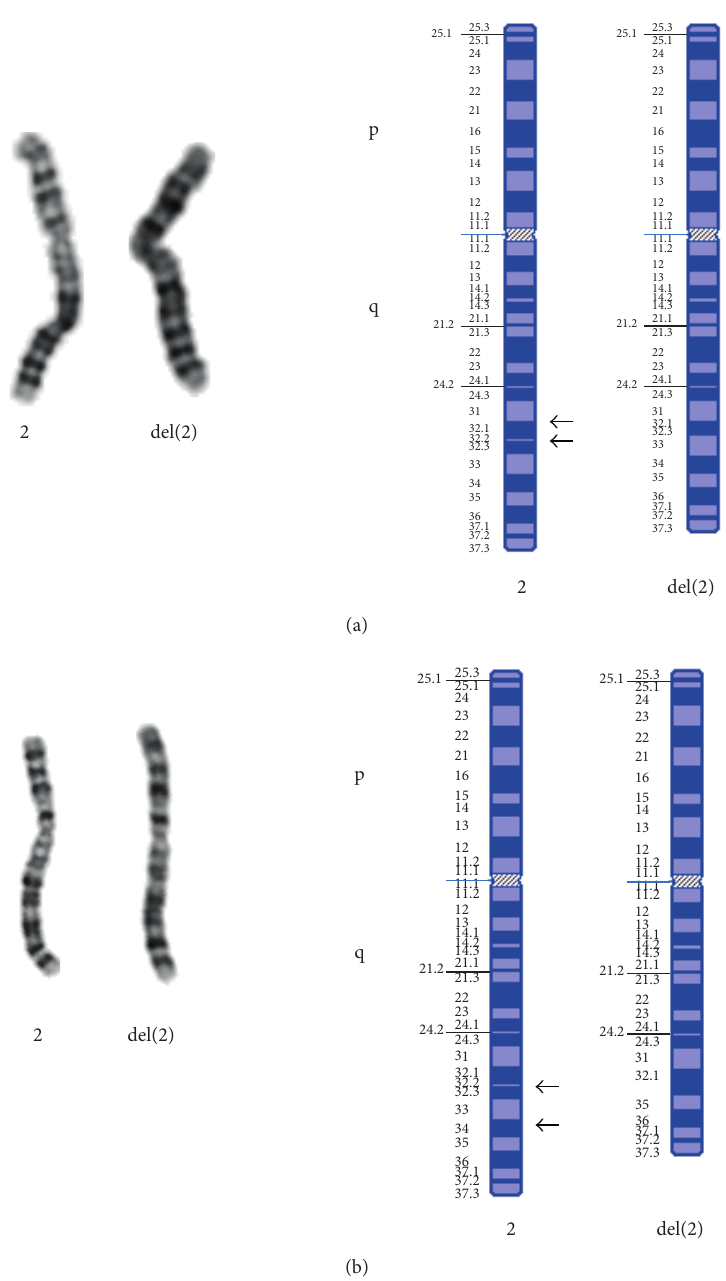
Figure 1: G-banded karyotype and corresponding ideogram of chromosomes 2. Panels (a) and (b) show the deleted chromosomes 2 for patients 1 and 3, respectively. The left hand of each panel shows the G-banded chromosomes, and the right side shows the corresponding ideograms. The horizontal black arrows show the location of the deletion breakpoints.